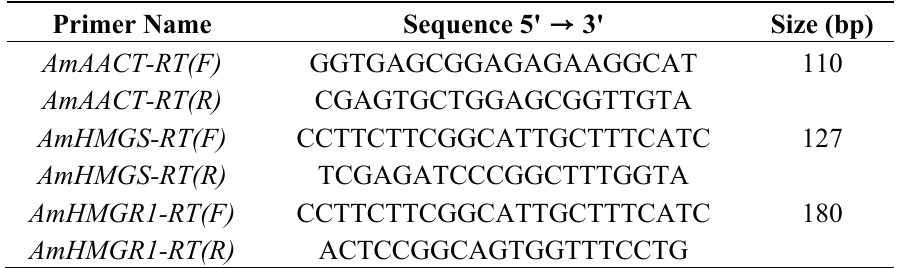
Table 2. Primers used in this